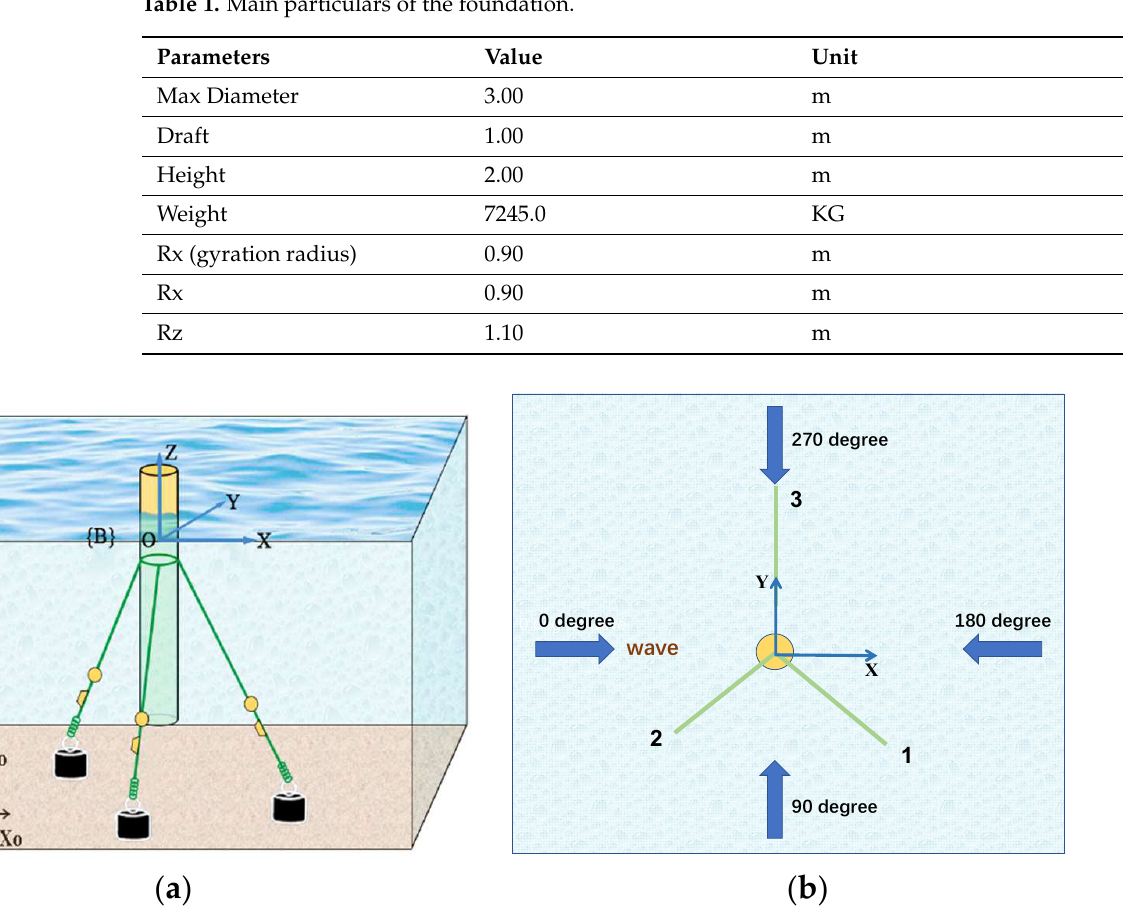
Table 2. Properties of mooring system.